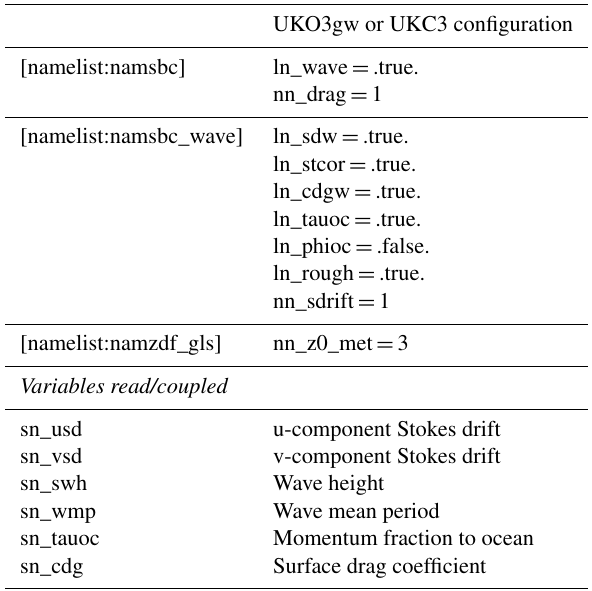
Table B1. Summary of NEMO namelist configuration settings for enabling wave-to-ocean forcing or coupling in